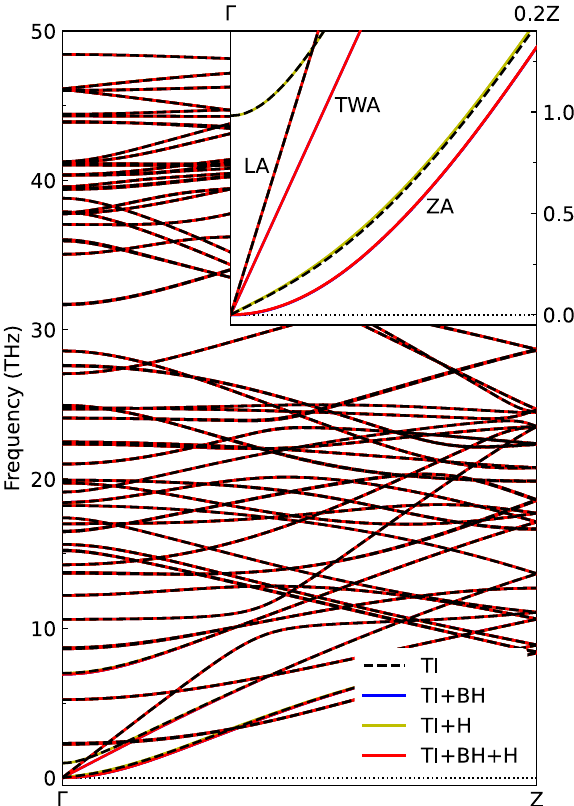
Fig. 5 Corrections due to the invariance conditions on the phonon dispersion of an infrared-inactive 1D single-wall (8,0) carbon nanotube. TI denotes the correction of translational invariance on the IFCs, while BH and H represent the corrections by Born-Huang rotational invariance and Huang conditions, respectively. The inset shows a zoom-in result around the Γ point, with four acoustic branches labelled as longitudinal acoustic (LA), twisting acoustic (TWA) and fl exural acoustic (ZA, doubly degen- erate) modes, respectively. The blue line coincides with the red one, which indicates the Huang conditions have no effect and the external stress is already vanishing after structural optimization.